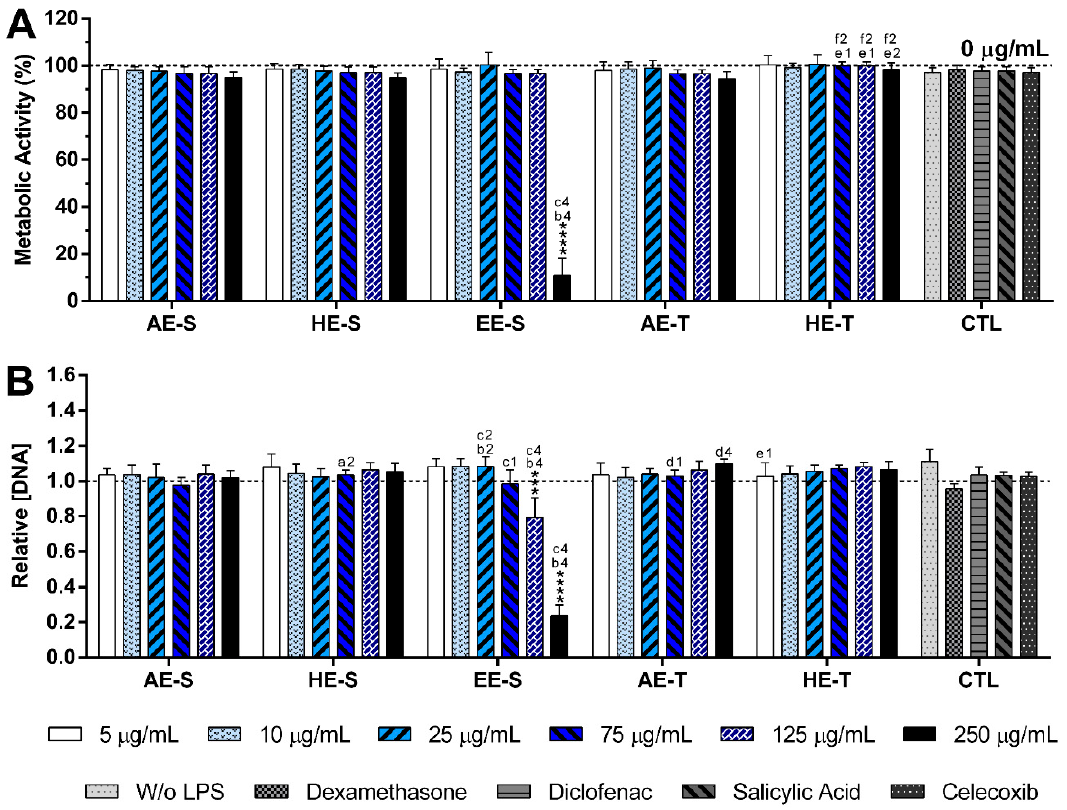
Figure 7. Metabolic activity ( A ) and relative DNA concentration ( B ) of LPS-stimulated macrophages cultured in the presence of di ff erent concentrations of the Salvia o ffi cinalis extracts and clinically used anti-inflammatory drugs (dexamethasone, diclofenac, salicylic acid and celecoxib, 10 µ M) for 24 h of culture at 37 ◦ C. The dotted line represents the nontreated condition (0 µ g / mL) for each assay. Statistically significant di ff erences are *** ( p < 0.0006) and **** ( p < 0.0001) in comparison to the negative control (0 µ g / mL) for each di ff erent tested extract, and 1 ( p < 0.0376), 2 ( p < 0.0090), and 4 ( p < 0.0001) in comparison with a (AE-S vs. HE-S), b (AE-S vs. EE-S), c (HE-S vs. EE-S), d (AE-S vs. AE-T), e (HE-S vs. HE-T), and f (AE-T vs. HE-T). AE: aqueous extracts; HE: hydroethanolic extracts; EE: ethanolic